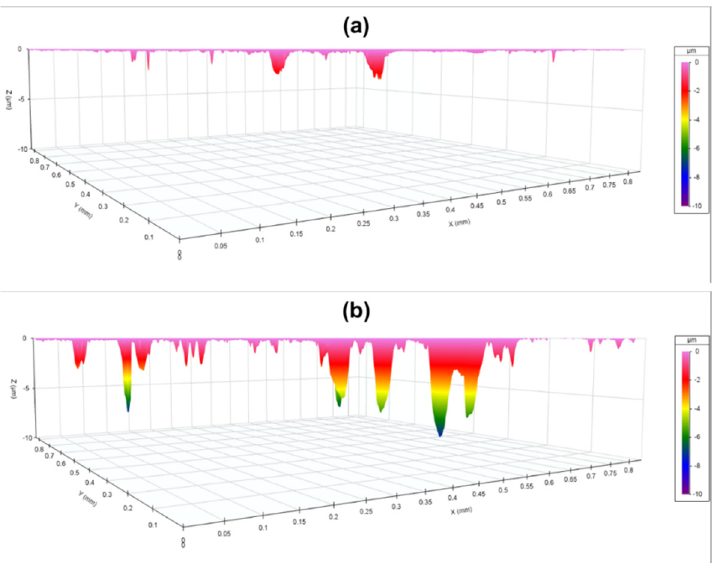
Figure 10. White light interferometry performed for pit depth analysis on the cast iron samples exposed to ( a ) 100 ppm and ( b ) 500 ppm chloride containing engine coolants for constant immersion up to 28 days (avg. pit depth 100 ppm – 2.73 µm and 500 ppm – 6.60 µm).